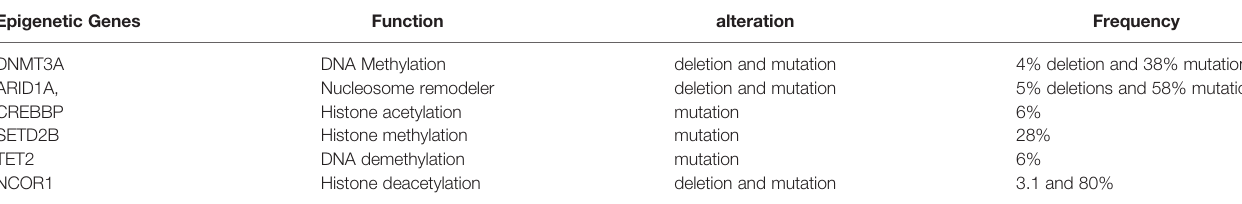
TABLE 4 | The mutational frequency of epigenetic related gene in CTCL (according to Park J et al. genomic analysis of 220